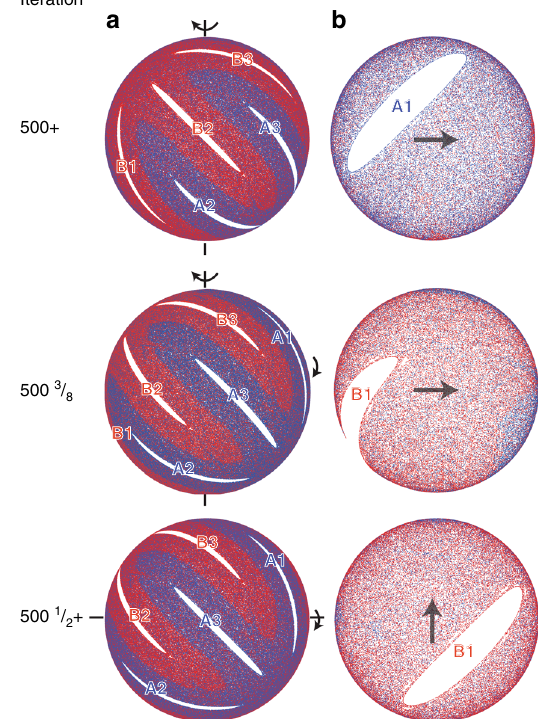
Fig. 10 Movement of emergent non-mixing regions through the fl owing layer. Emergent non-mixing regions (A1-A3, B1-B3) appear only for ϵ > 0 (i.e., non-existent in the PWI model) and their accompanying ‘ fi ngers ’ alternate between being fully contained in the fl owing layer or in the bulk after each half-iteration for the (45°, 45°) protocol. Views from below of a the hemispherical shell and b the planar fl owing layer for ϵ = 0.15. Labels of periodic regions illustrate changes in orientation. Animations are provided in Supplementary Movie 2. Arrows in b indicate the direction of fl ow in the fl owing